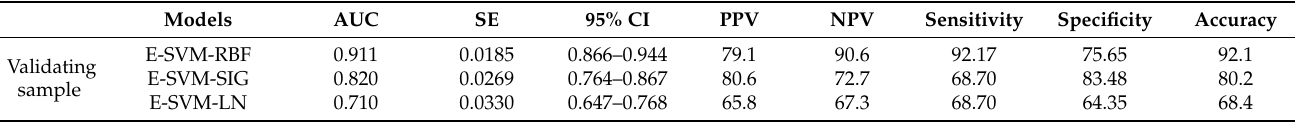
Table 4. Statistical metrics used to evaluate the models’